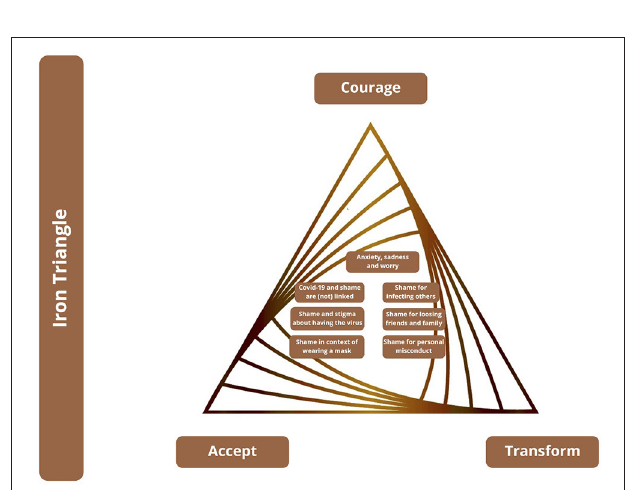
FIGURE 4 | Findings with regard to the Iron Triangle, based on Wong